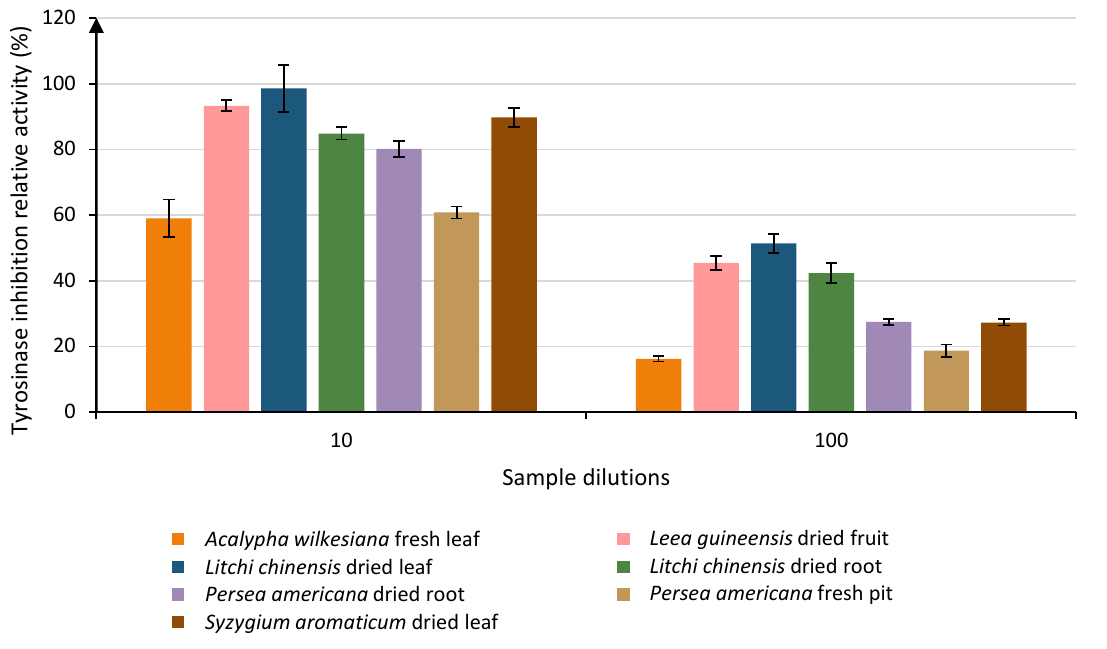
Figure 3. Evolution of the relative tyrosinase inhibition activities of the most efficient samples through 2 different dilutions of 10 and 100 that were above the LOQ. Each column represents the mean ± SD ( n = 3) per sample. Table 4. Anti-tyrosinase activity results for the plant extracts diluted 10 and 100 times ( n = 3). Results were statistically analyzed using Tukey’s grouping test (confidence level: 95%), and the observed group classifications (A,B,C…..etc.) are shown in the present table.